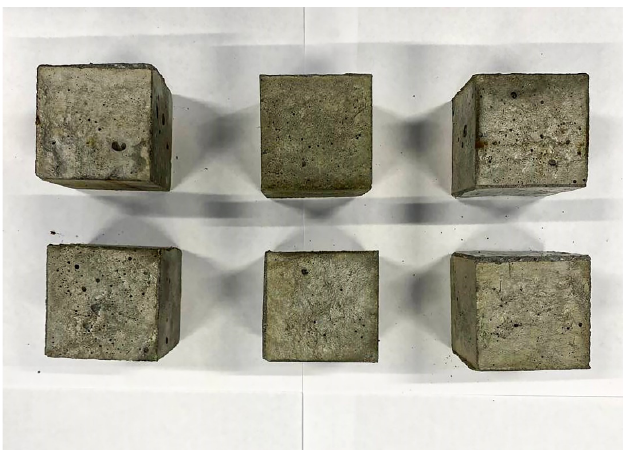
Figure 3. Photo of control samples.